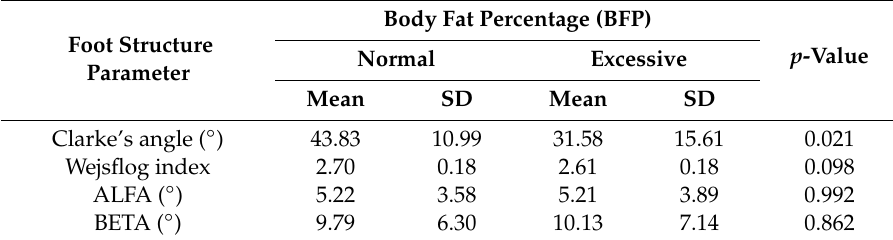
Table 2. Assessment of foot structure indices and body fat percentage.